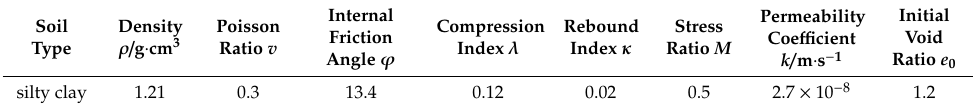
Table 1. Physical and mechanical parameters of soil.